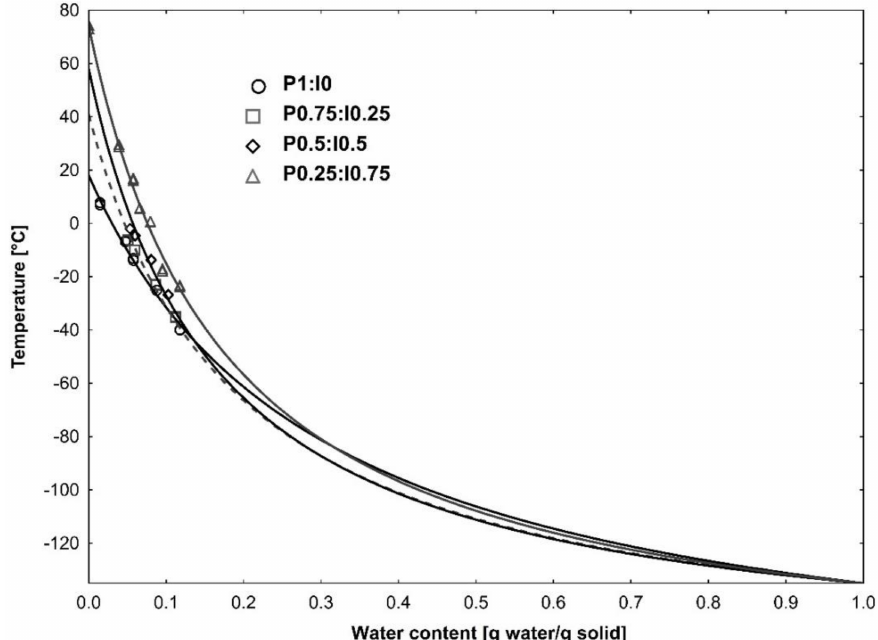
Figure 3. Glass transition temperature as a function of solids content for pumpkin powder produced with different inulin additions fitted by Gordon–Taylor model, P1:I0 data from ref.